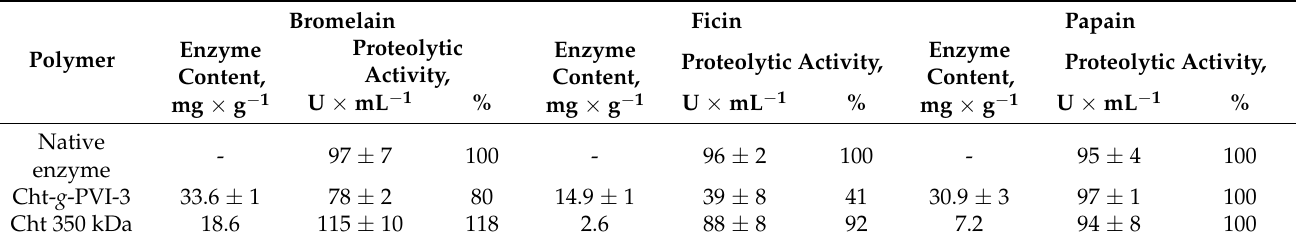
Table 4. The characterization of the immobilized